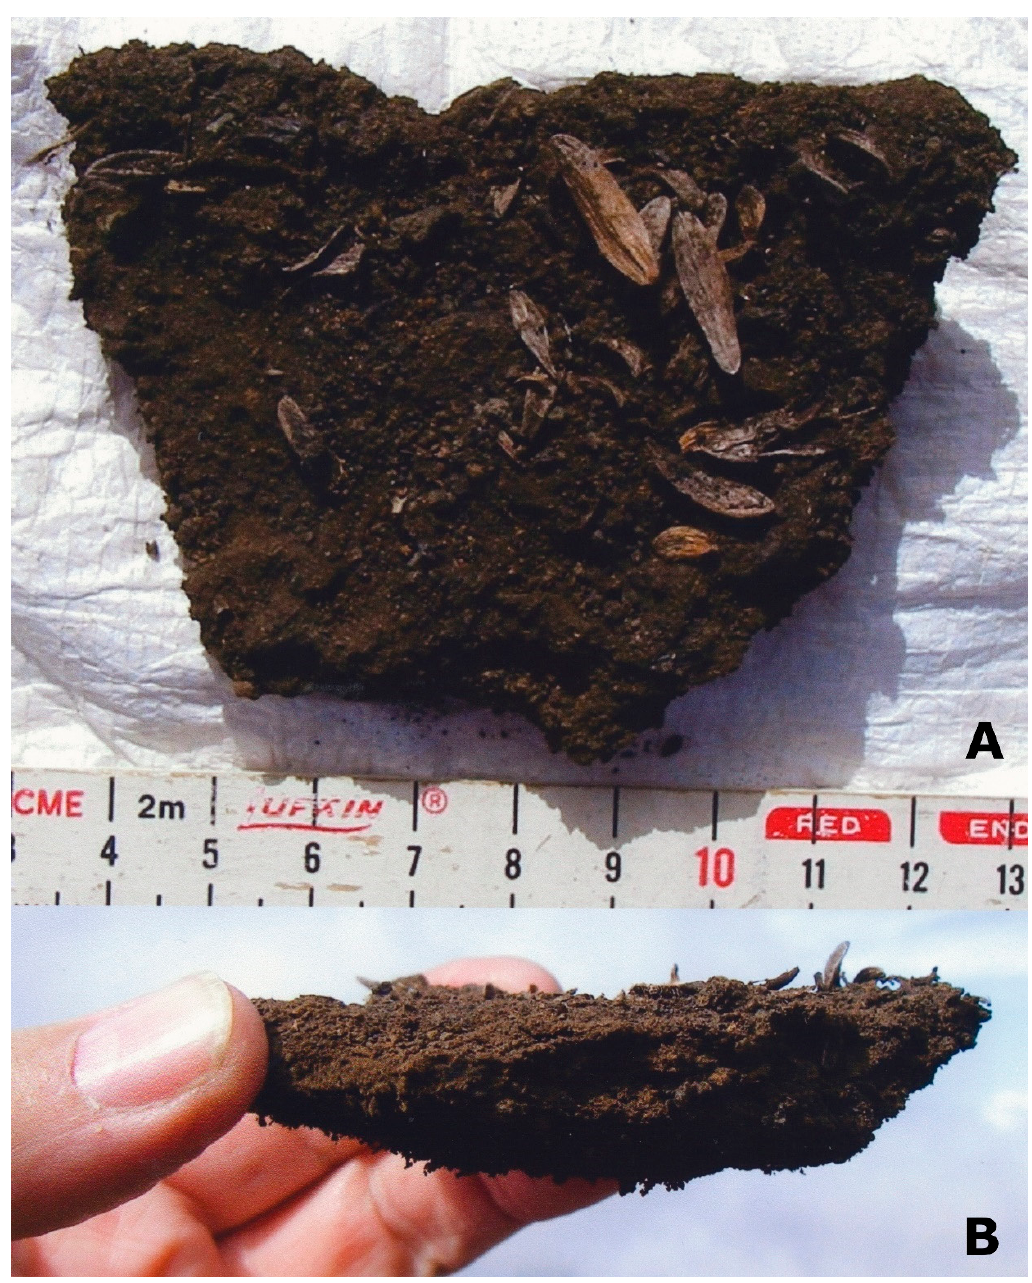
Figure 5. Aggregated crust horizon under Oi1 litter horizon, gathered below a 265-cm-wide k ū paoa shrub at ~2660 m. ( A ) Top view, upper crust surface; several k ū paoa leaves remain attached or embedded within the dark horizon. This fragment is ~98 × 72 mm; scale is in cm. ( B ) Side view of the same fragment; maximum thickness at center is ~26 mm. Photos: Hk-256-14 and Hk-258-14, 10 September 2014.